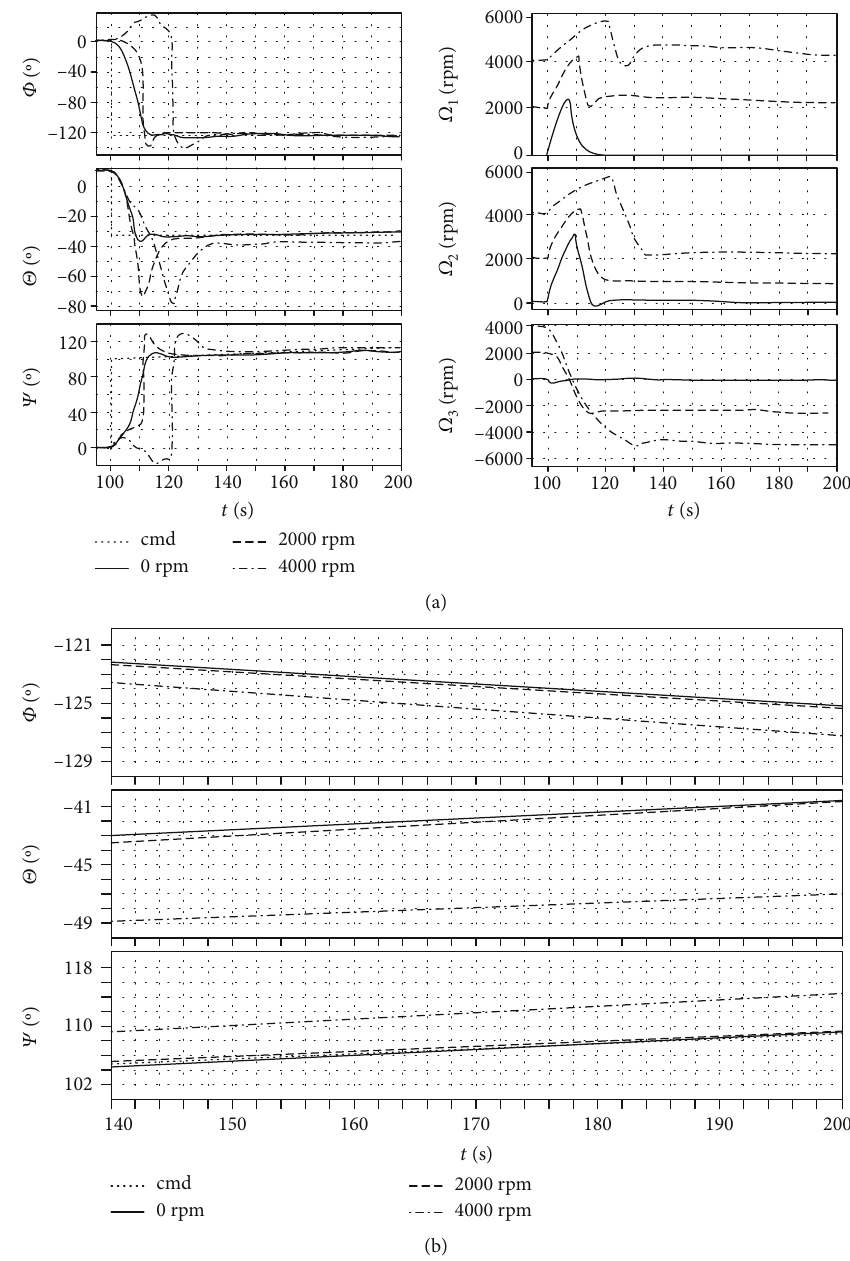
Figure 9: (a) Nominal mode, case 3; (b)